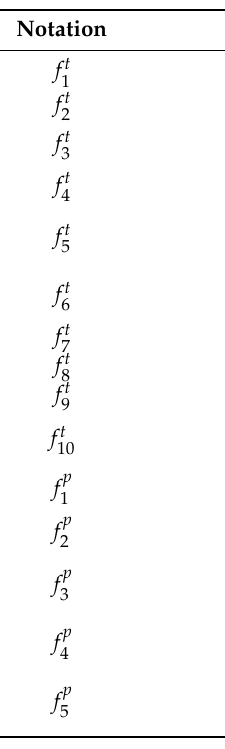
Table 1. Detailed description of statistical